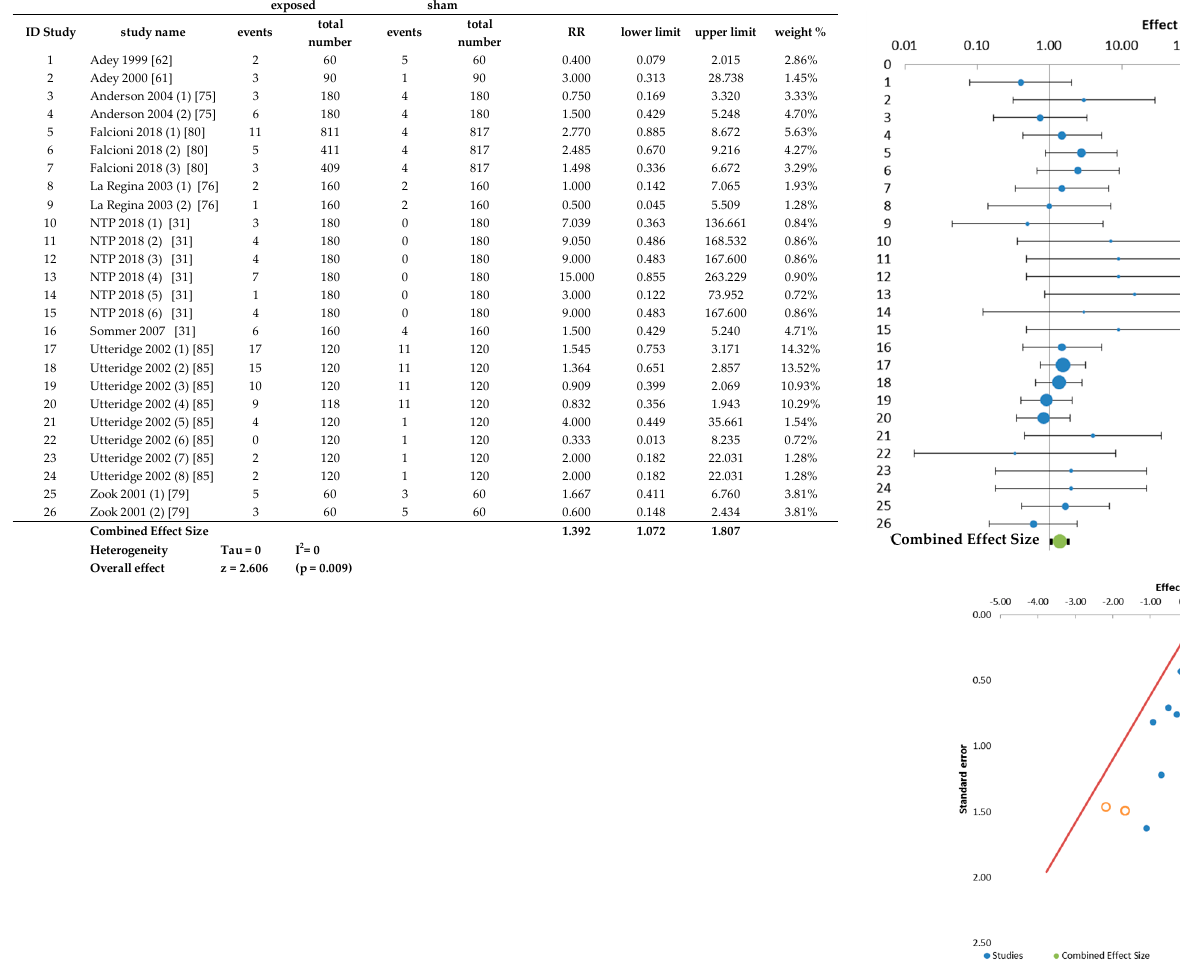
Figure 5. Forest plot and raw data of the brain malignant tumors.